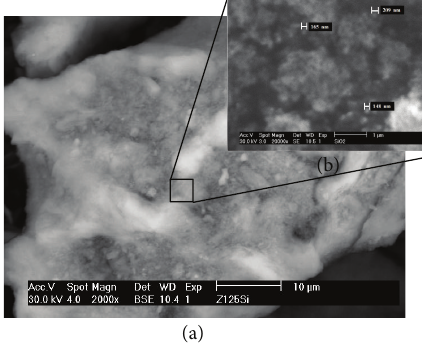
Figure 2: SEM images of (a) zeolite with 12.5% of SiO 2( agglomerates at high SiO 2( NPs )